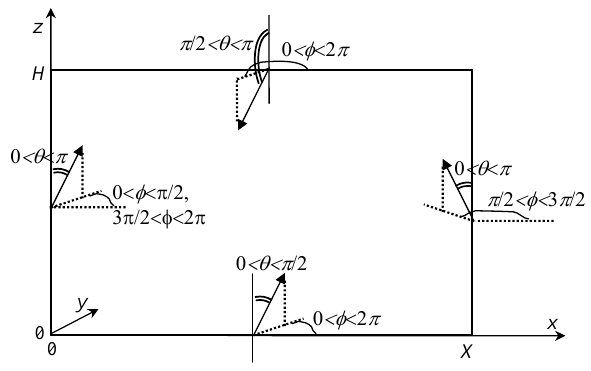
Fig. 3. The 2-D region and directions of entering